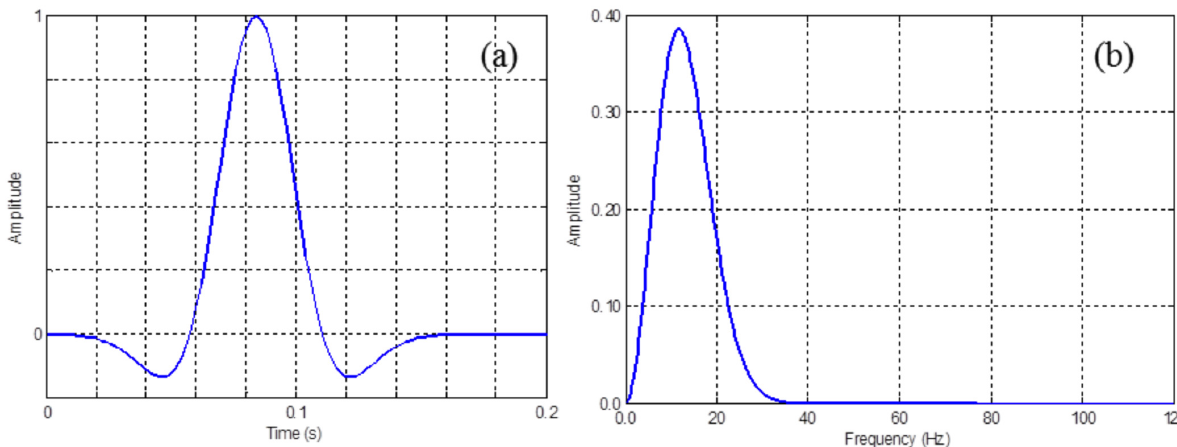
Figure 3. (a) The source wavelet; (b) corresponding spectrum for forward modeling.